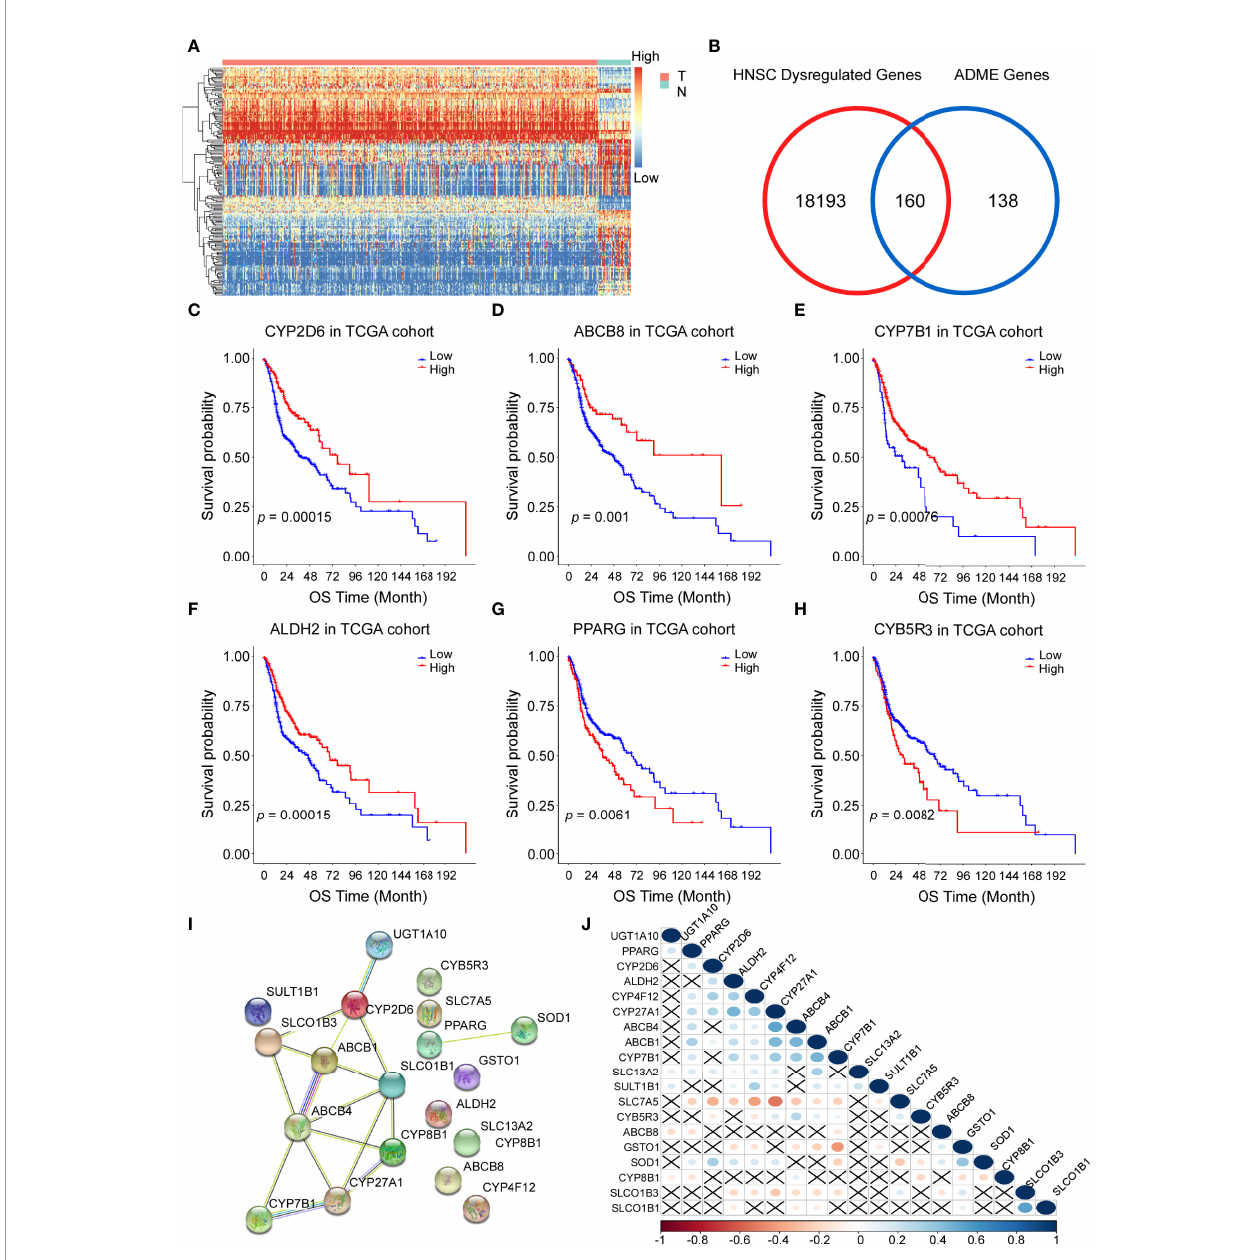
FIGURE 2 | Identi fi cation of prognostic genes involved in drug absorption, distribution, metabolism, and excretion (ADME) in the Cancer Genome Atla (TCGA) cohort. (A) Heatmap showing the gene expression pro fi les of tumor (T) and normal (N) tissues. High, high expression; Low, low expression. (B) Venn diagram to show differentially expressed ADME genes. (C – H) Kaplan – Meier curves of overall survival (OS) for 6 representative prognostic ADME genes in HNSCC, all P <0.01. (I) A PPI network indicating the interactions among the 19 prognostic ADME genes. (J) Spearman correlation analysis of the 19 ADME